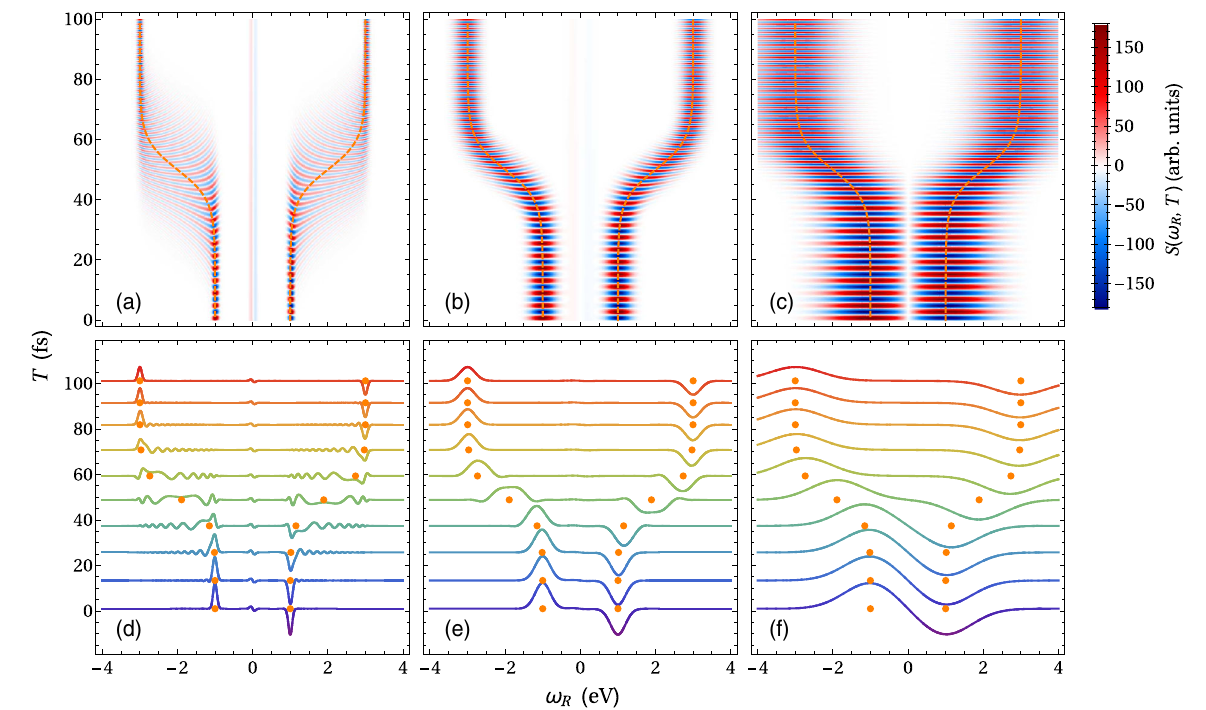
FIG. 8. CTRUECARS signal with two coherent phase-controlled pulses. The signal [Eq. (23)] is exhibited for a broadband pulse ˜ E ω Þ of width σ 10 eV ( 1 = σ 66 as) and a narrow-band pulse ˜ E ω Þ of width (a),(d) σ 2 ð 2 ¼ 2 ¼ 1 ð σ 0 . 2 eV ( 1 = σ 3 . 3 fs), and (c),(f) σ 0 . 7 eV ( 1 = σ 0 . 94 fs). The signal is shown (a) – (c) as a function of the time delay T and 1 ¼ 1 ¼ 1 ¼ 1 ¼ the Raman frequency ω , and (d) – (f) for selected time delays. The orange dashed line in (a) – (c) and the orange dots in (d) – (f) display the R t Þ in Eq. (18). The carrier frequencies of the pulses must be such that j ω time-dependent frequency ω ba ð Good temporal and spectral resolutions are